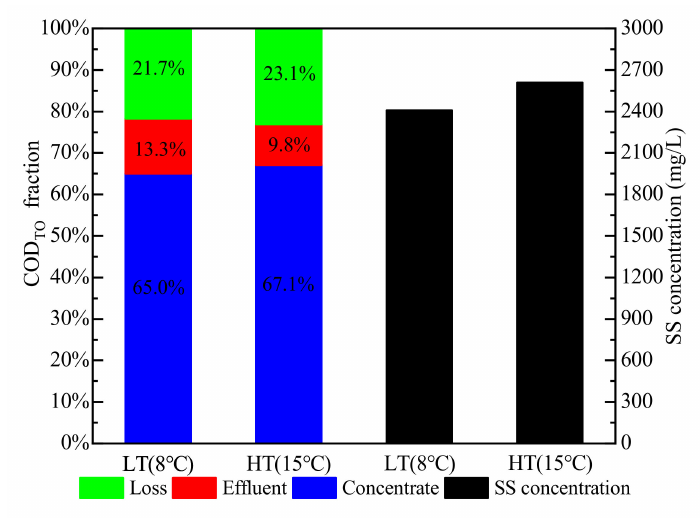
Figure 2. COD TO mass balance at di ff erent temperatures and SS concentrations.